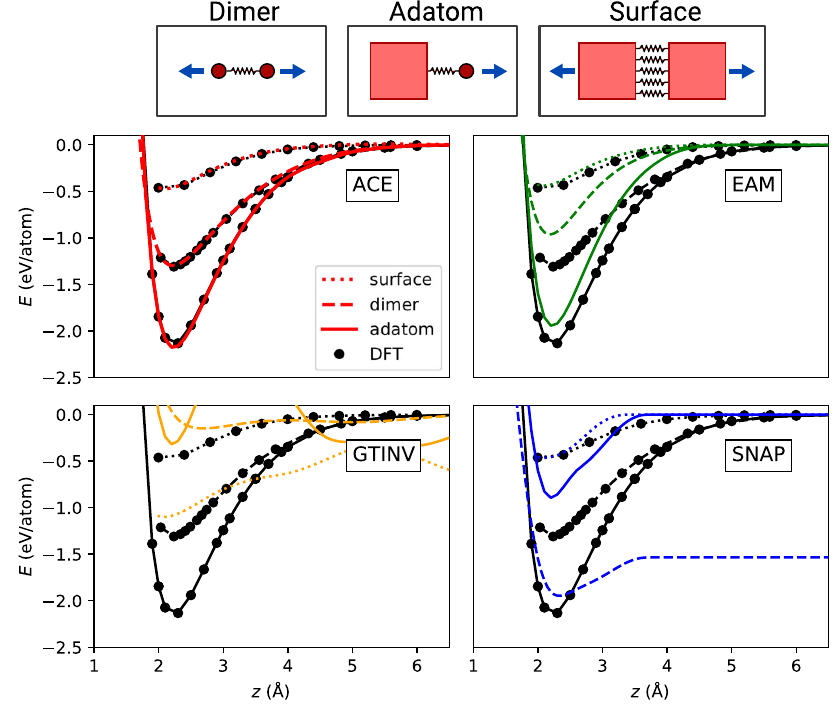
Fig. 5 Decohesion in different environments. Comparison of Cu dimer dissociation to a detachment of the “ on-top ” Cu adatom from the (111) surface and a rigid decohesion of two Cu bulk slabs along the 〈 111 〉 direction.